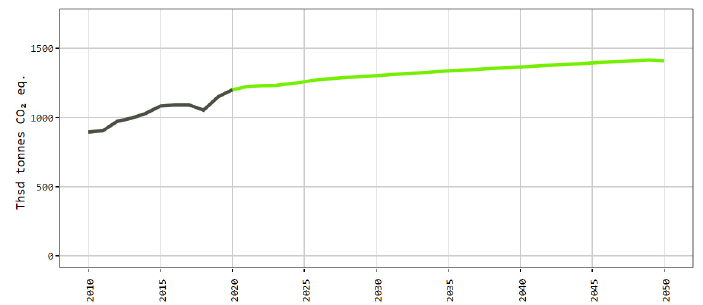
Figure 25. GHG emissions from agricultural soil management in Latvia in 2010–2020, with a projec- tion for 2021–2050, thousands of tons CO 2 equivalent [62].